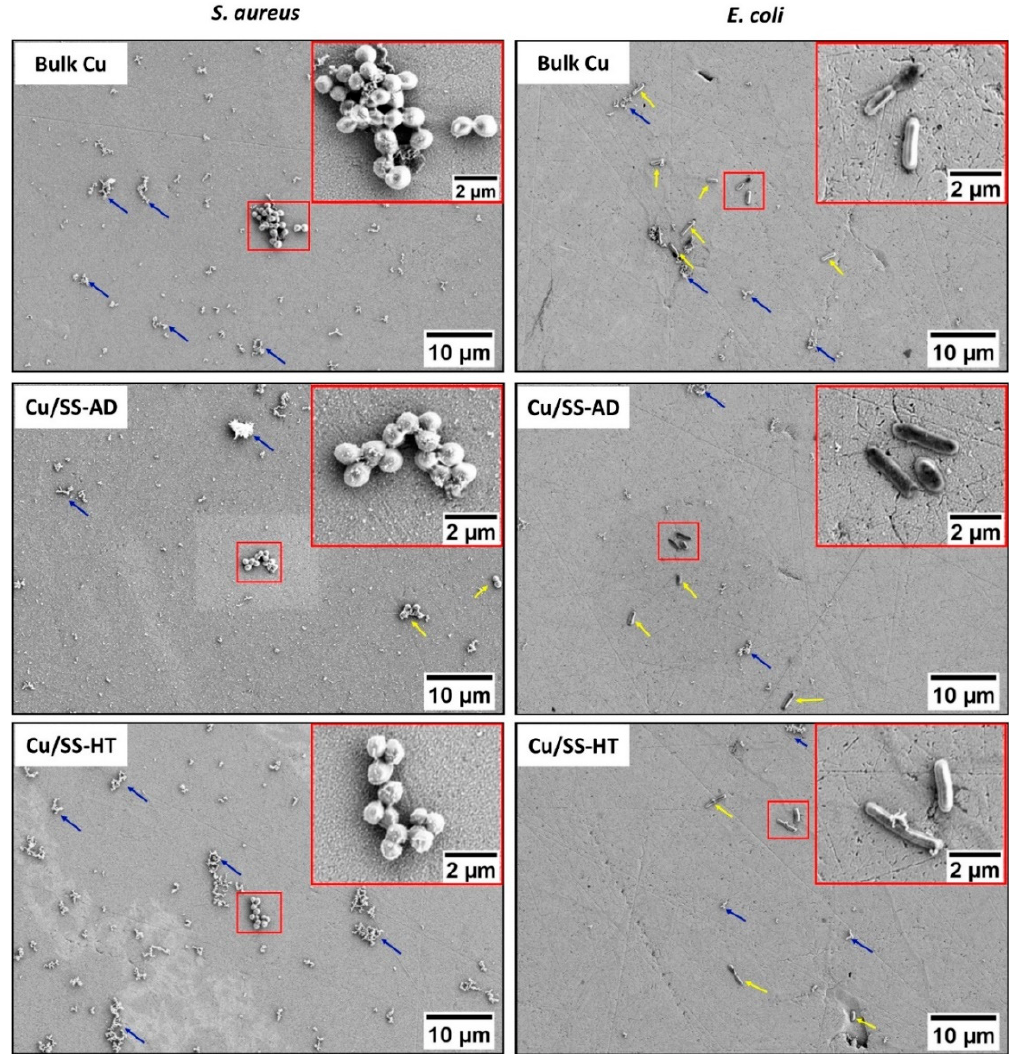
Figure 4. SEM images showing the morphology of S. aureus and E. coli bacterial cells attached to control glass samples after 15 min exposure.